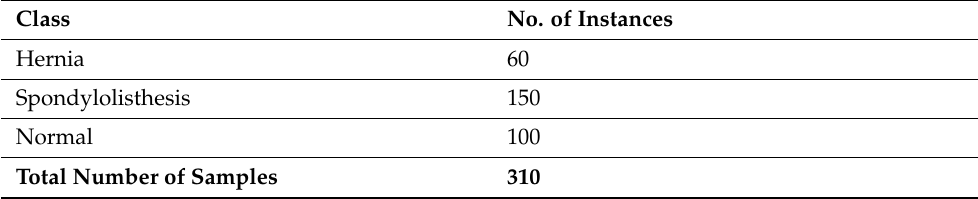
Table 1. Dataset